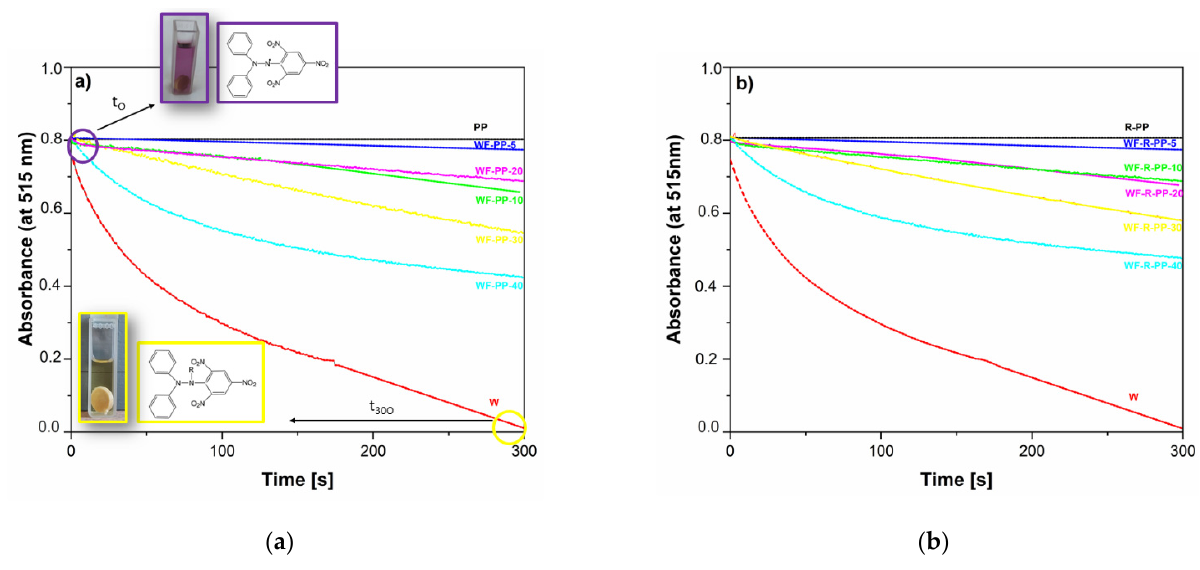
Figure 16. The absorbance as a function of time of ( a ) WF-PP composites and ( b ) WF-R-PP composites. Table 3. Antioxidant activities of WF-PP and WF-R-PP composites represented by the percental decrease of absorbance of DPPH at 515 nm after 100, 200 and 300 s.